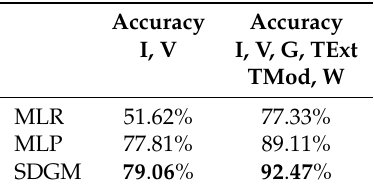
Table 2. Fully supervised baselines of MLR, MLP, and SDGM with the simple sensor input, {I, V}, and the complex input, {I, V, G, TExt, TMod, and